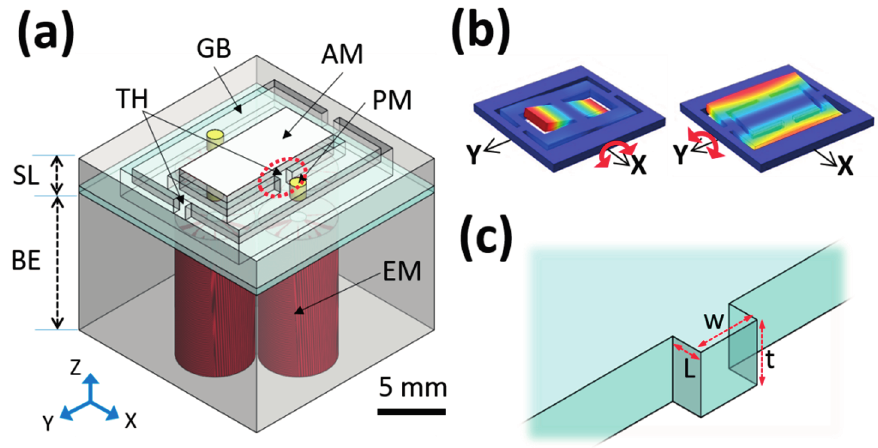
Figure 1. Design of the 2A-PDMS-WP-scanner. ( a ) 3D scheme of the 2A-PDMS-WP-scanner; ( b ) Scheme of torsional motions along the X and Y axes; ( c ) Magnified view of a torsional hinge. SL, structure layer; BE, block of four electromagnets; AM, aluminum mirror; PM, permanent magnets; EM, electromagnets; GB, gimbal; and TH, torsional hinges. The resonant